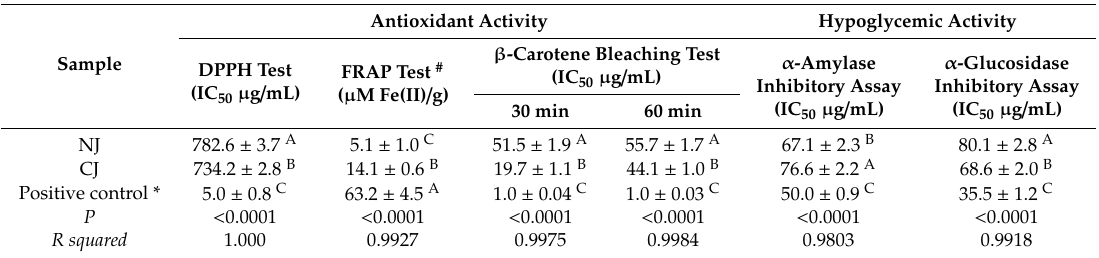
Table 2. In vitro antioxidant and hypoglycemic properties of natural and clarified pomegranate juices.